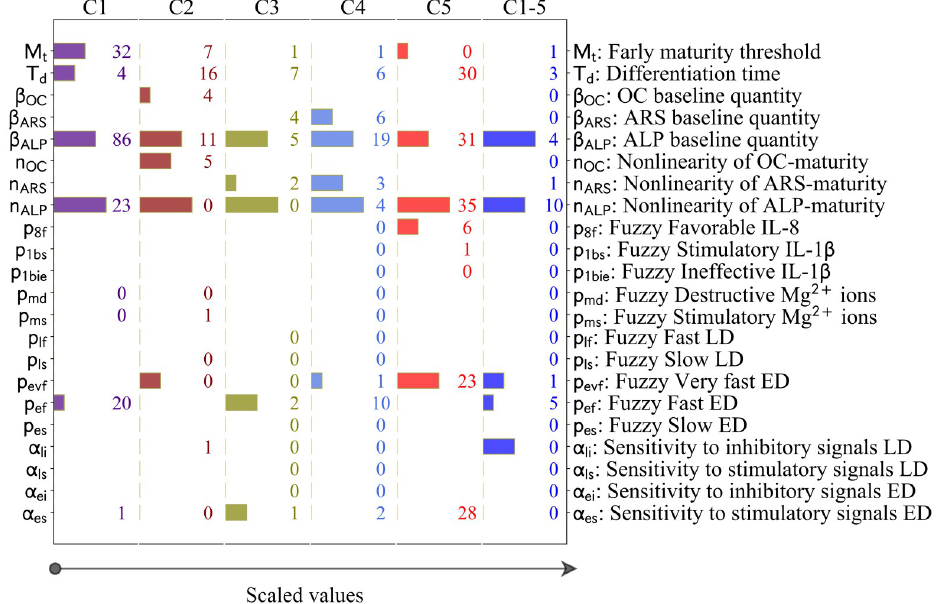
Fig 9. Results of the sensitivity analysis obtained during different calibration scenarios of C1, C2, C3, C4, C5 and C1-5. The bars indicate the five most significant parameters, given on the scale of 1 to 5, obtained from LSSP. The numbers show the results of SSIP in percentage. Those parameters with no values were not involved in that particular study.